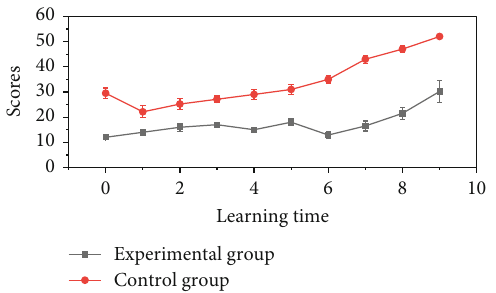
Figure 3: Descriptive statistics of English reading pretest scores of the control class and the experimental